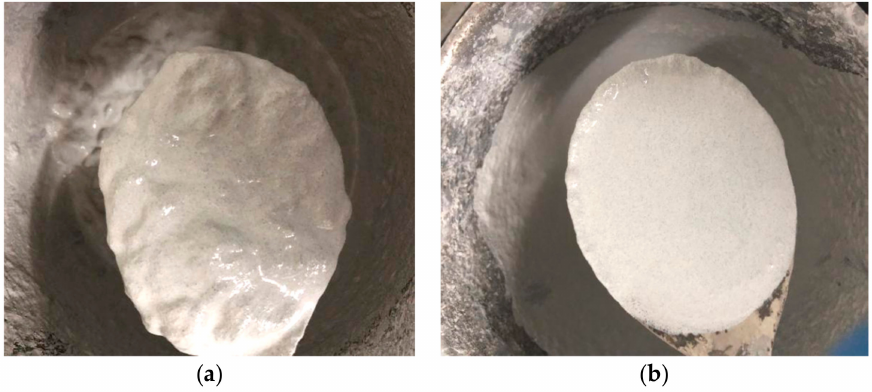
Figure 8. Flow state of ECC mortar. ( a ) Dosage 3%, w / c 0.24; ( b ) Dosage 2%, w / c 0.23.